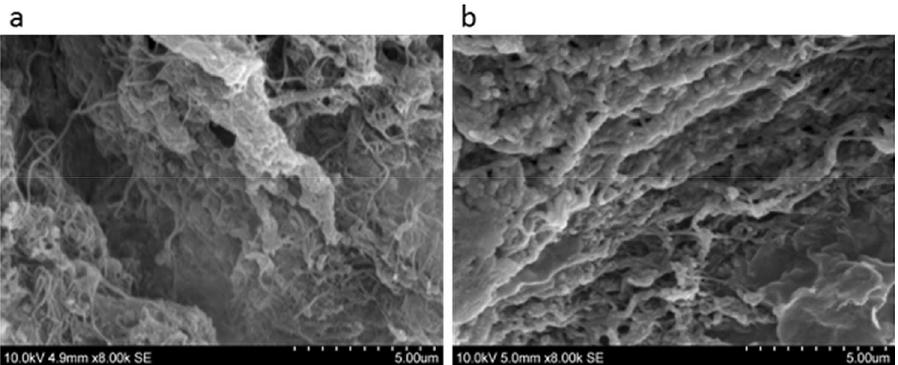
Figure 4. Scanning electron microscopy surface assessment. ( a ) Control rat dental pulp tissues reveal a complex irregular fibre mesh structure. ( b ) Decellularised tissue show structural preservation. Scale bar at 5 µm.